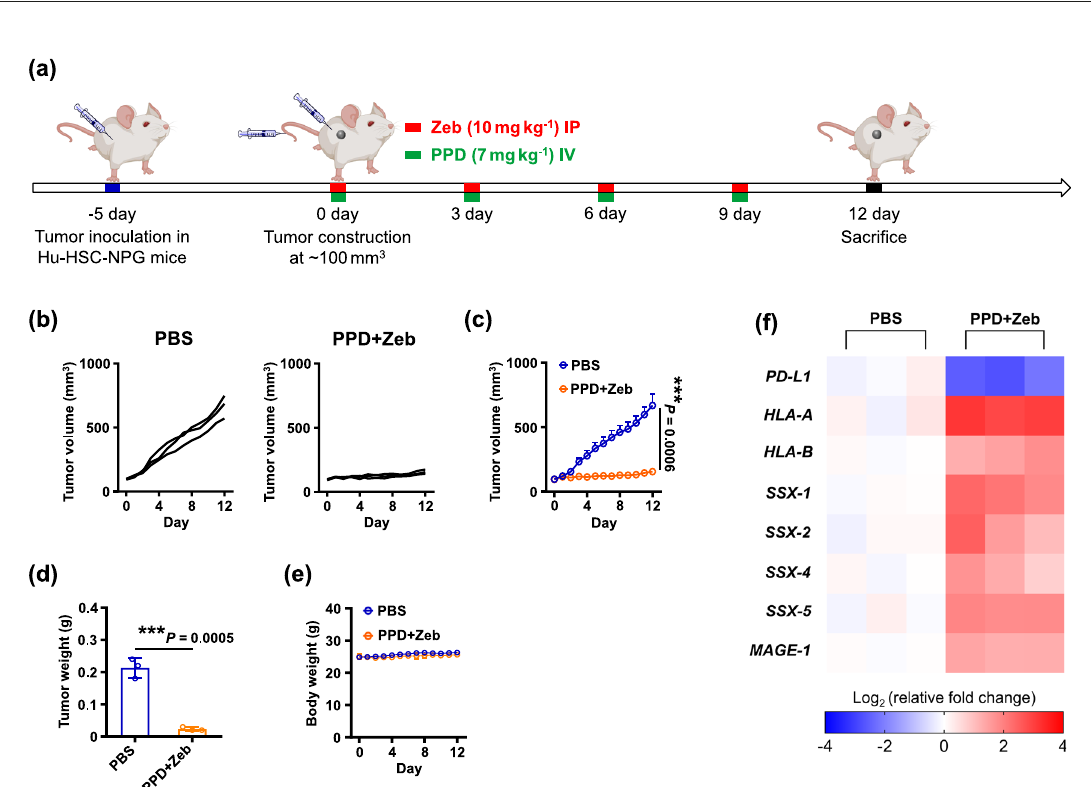
Fig. 7 PPD combined with Zeb inhibited 4T1 tumour metastasis. a Therapeutic schedule for PPD plus Zeb-mediated inhibition of 4T1 tumour metastasis. b Representative H&E-stained lung slice images at the end of treatment, the red dashed area indicated tumour metastasis, scale bar: 100 μ m. c Representative H&E-stained liver slice images at the end of treatment, the red dashed area indicated tumour metastasis, scale bar: 100 μ m. d Representative fl ow cytometric analysis of TEM (CD44 + CD62L − ) and TCM (CD44 + CD62L + ) cells gating on CD8 + T cells in spleen of 4T1 tumour- bearing mice at the end of the treatment. e Representative fl ow cytometric analysis of TEM (CD44 + CD62L − ) and TCM (CD44 + CD62L + ) cells gating on CD4 + T cells in spleen of 4T1 tumour-bearing mice at the end of the treatment. Relative quanti fi cation of f TEMs and g ratio of TEMs / TCMs gating on CD8 + T cells in the spleen of 4T1 tumour-bearing mice at the end of the treatment. Relative quanti fi cation of h TEMs and i ratio of TEMs / TCMs gating on CD4 + T cells in the spleen of 4T1 tumour-bearing mice at the end of the treatment. Data in f – i are presented as mean ± SD, n = 4 biologically independent samples in f – i . P -values are calculated by the two-tailed Student ’ s t -test in f – i as indicated in the fi gures. ** P < 0.01 and *** P < 0.001. A representative image of three independent samples from each group is shown in b and c .